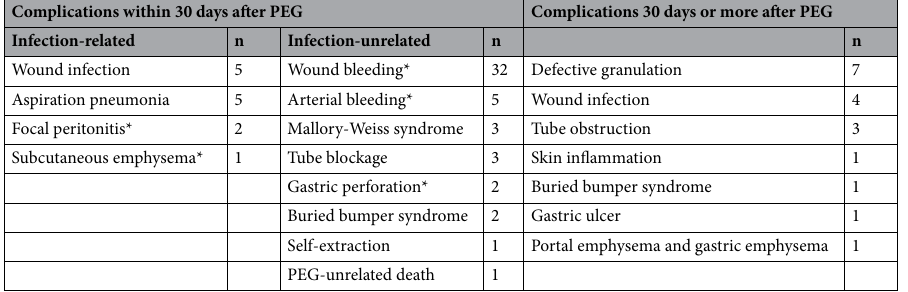
the PEG site at the PW of the GC: one with gastroepiploic artery bleeding (case 1) and the other with gastric perforation (case 2), as described below. The severe acute complications in the remaining two cases were related to the PEG procedure not with the PW of the GC. One patient who was complicated with an abscess as a severe complication case at 30 days or more after PEG received surgical abscess drainage (Table 2).